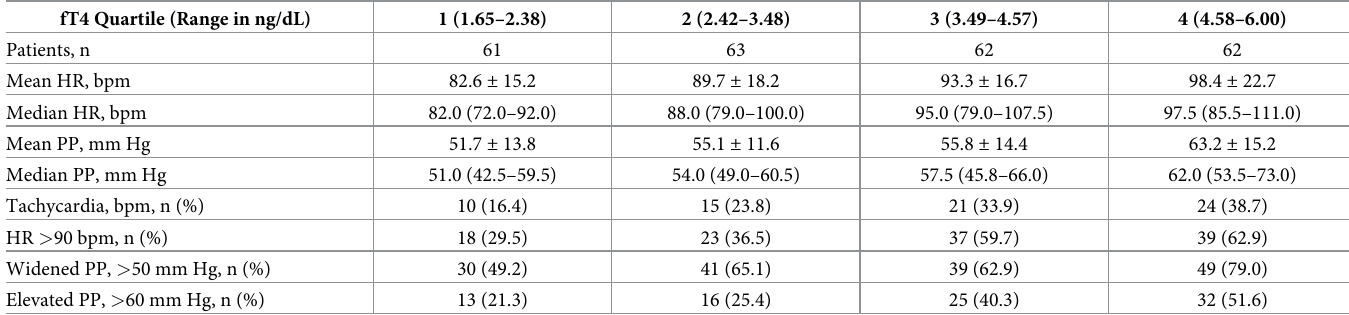
Table 2. Thyroid function and cardiac values per fT4 quartile.